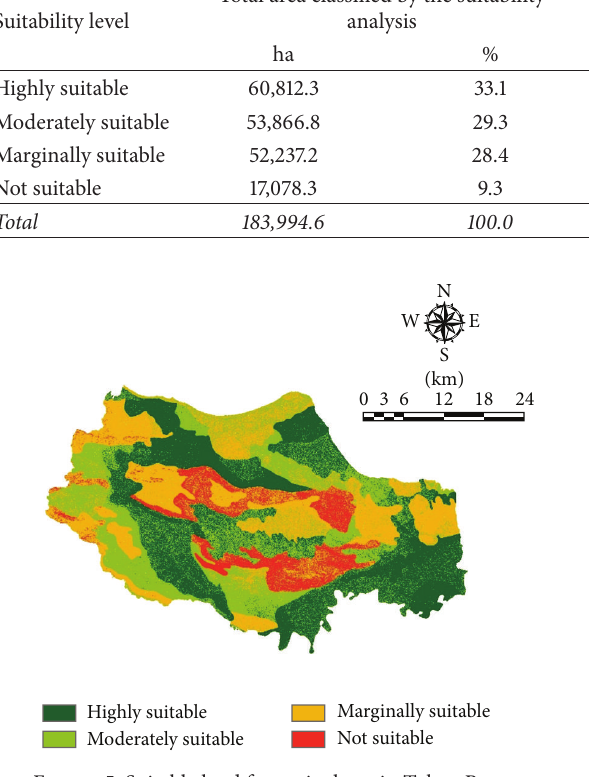
Figure 5: Suitable land for agriculture in Tuban Regency.